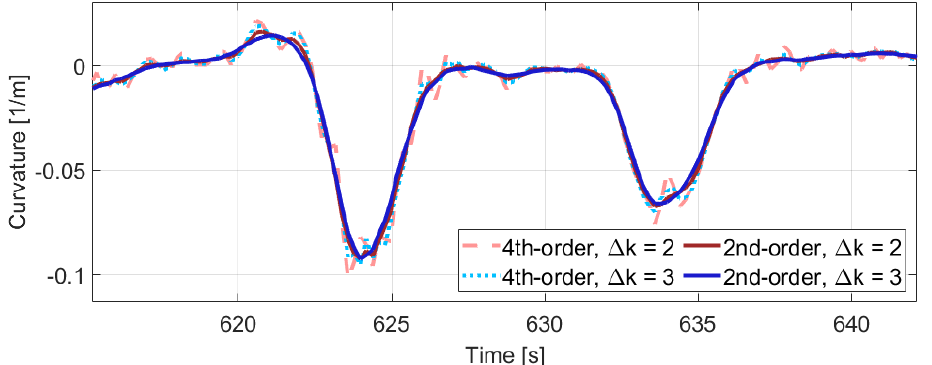
Figure 6. Part of the estimated curvature